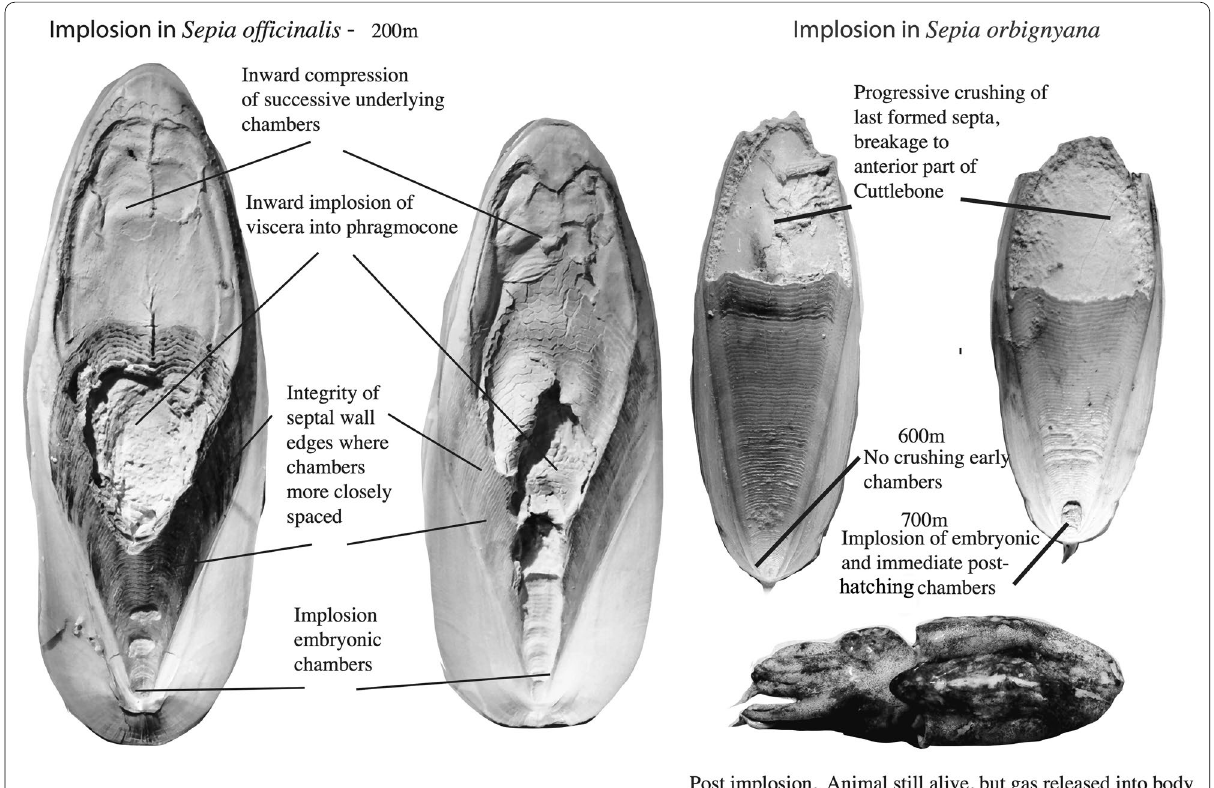
Fig. 3 Implosion morphology of shallow, and deep-water sepiids. In shallow water forms, as illustrated by Sepia officinalis , implosion occurs along entire length of cuttlebone. In deep-water species, implosion occurs as sequential compression of latest